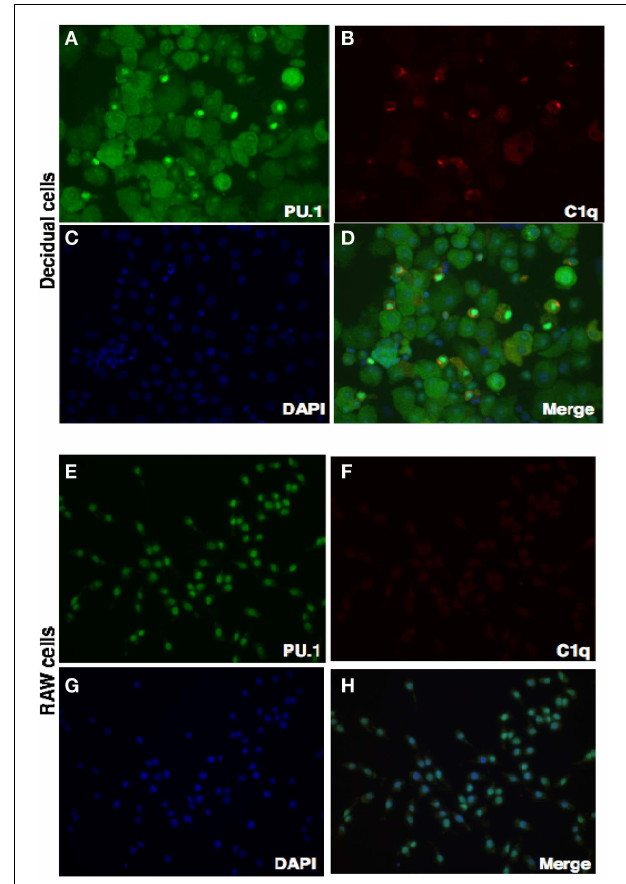
FIGURE 8 | Double intracellular immunofluorescence staining of PU.1 and C1q in first trimester decidua . Decidual cells cytospun were fixed, permeabilized, and immunostained with mouse anti-human CK-7 and rabbit anti-human PU.1 antibodies.This was then probed with goat-anti-mouse Cy3 and anti-rabbit FITC conjugates, counterstained with DAPI and analyzed by Axiolmager Z1 fluorescent microscope (A–D) . RAW cells were used as controls treated and analyzed as decidual cells (E–H) . Original magnification for decidual cells and RAW cells are 20 ×